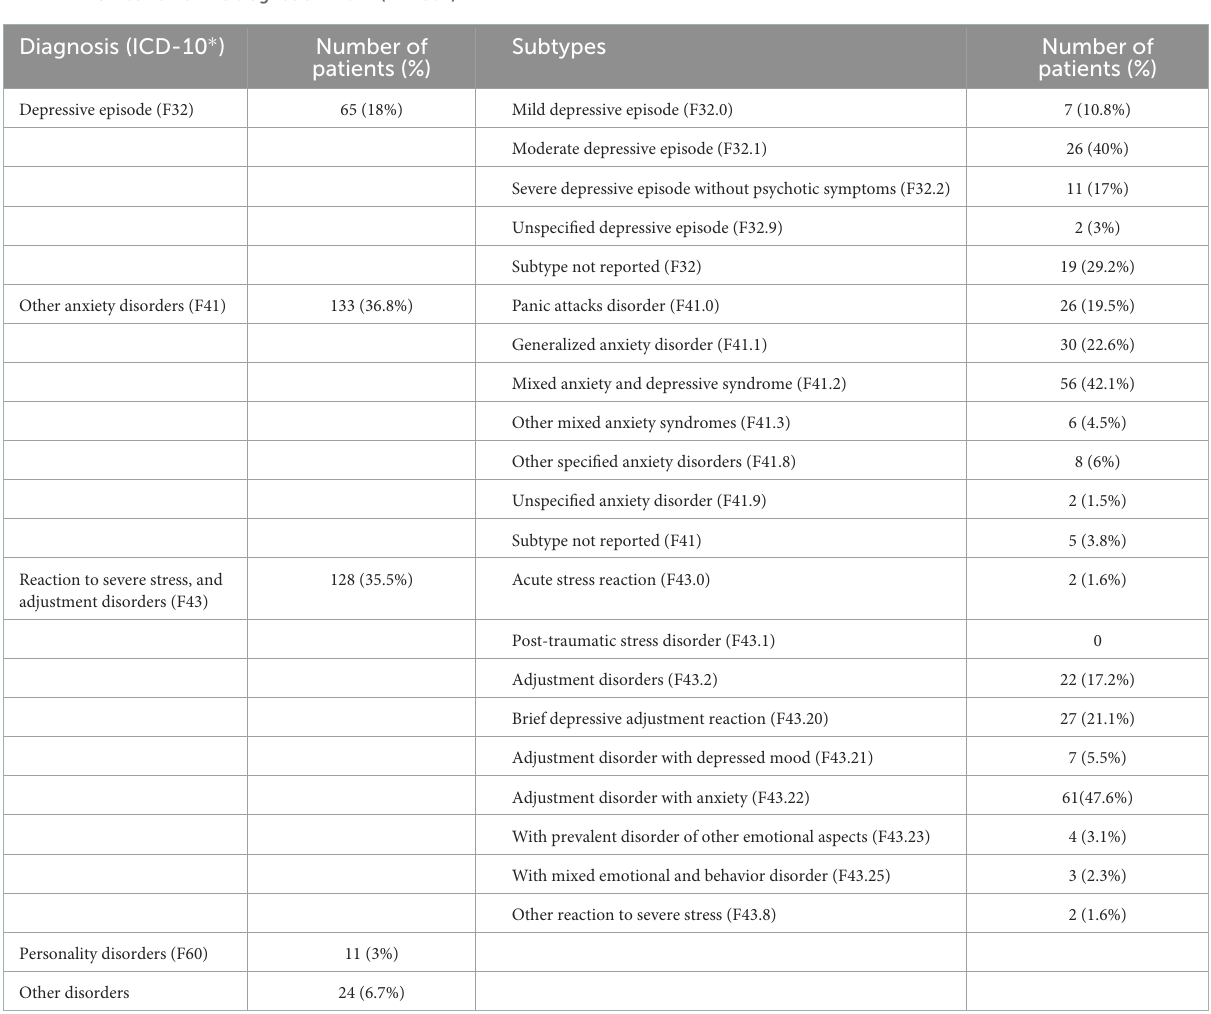
TABLE 1 Distribution of the diagnosis in 2021 ( N =